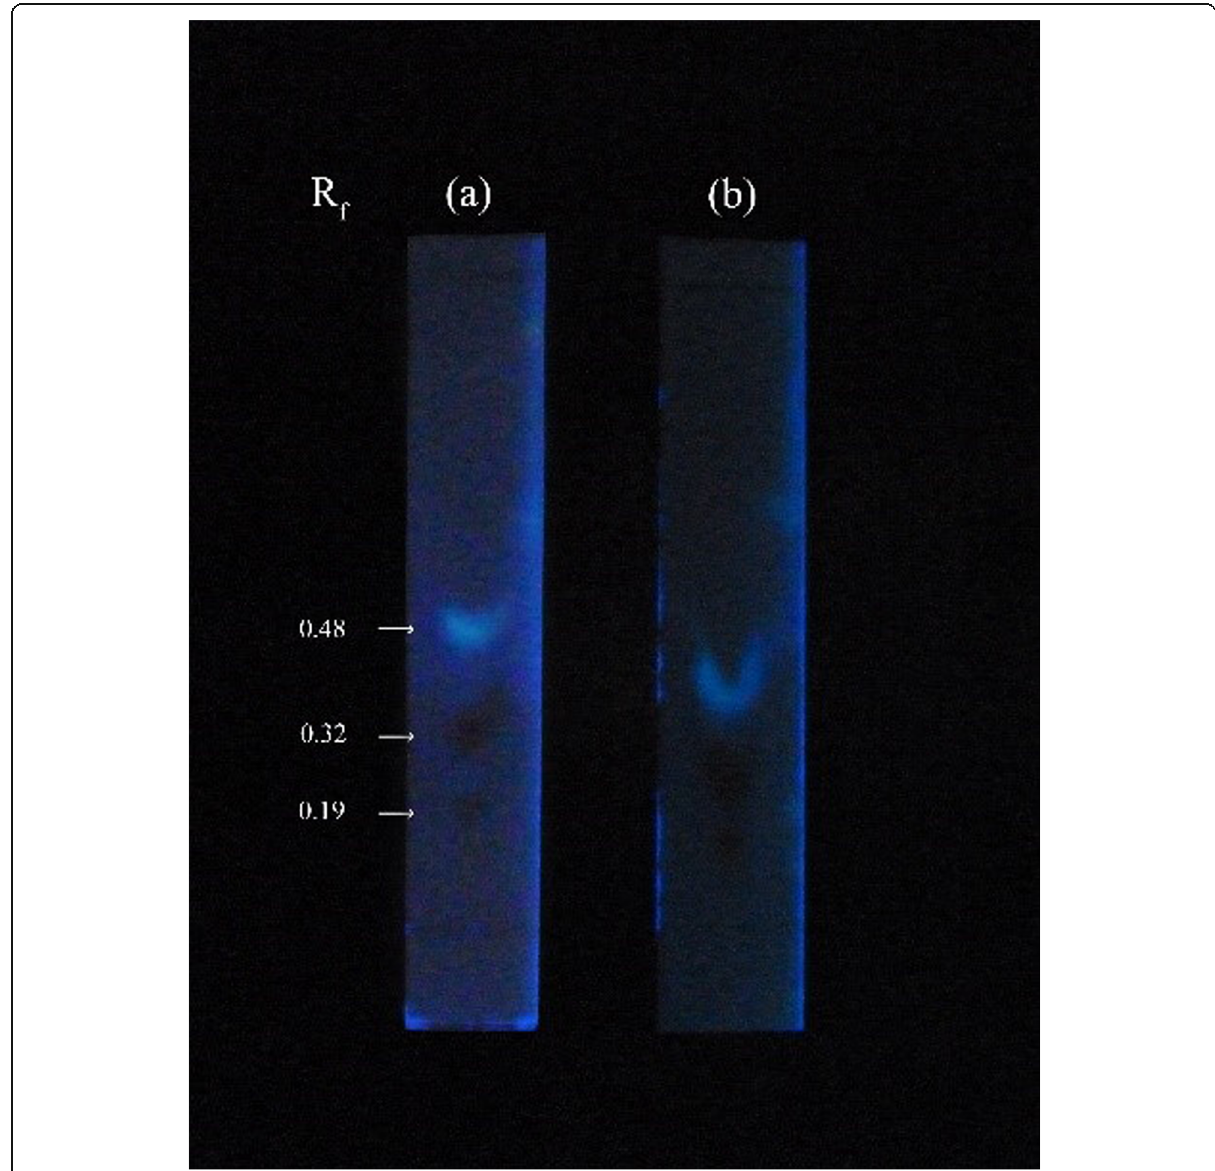
Fig. 4 TLC profiles resulting from the chemically elicited cell suspension ( a ) SA 0.5 μ M and ( b ) MJ 0.1 mM on the 6th